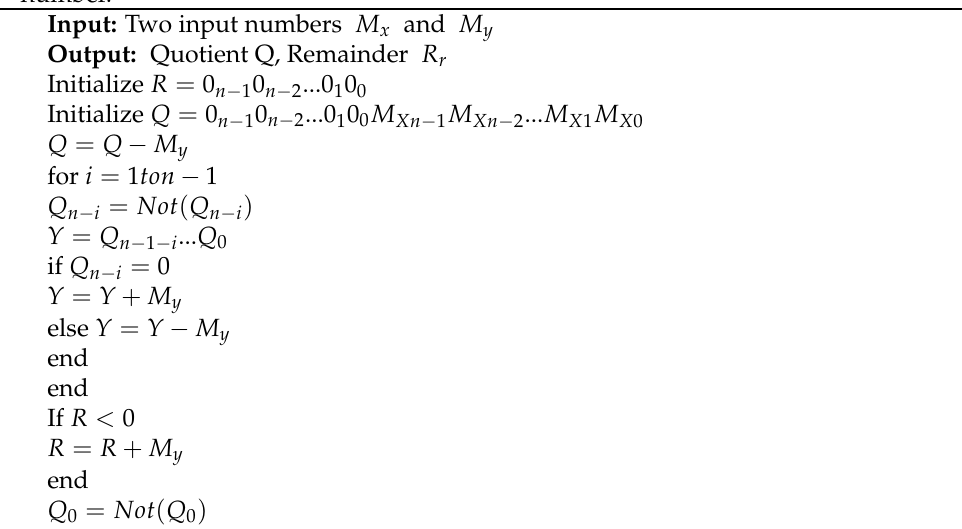
Algorithm 3: Non-restoring division algorithm for mantissa of the floating-point number.